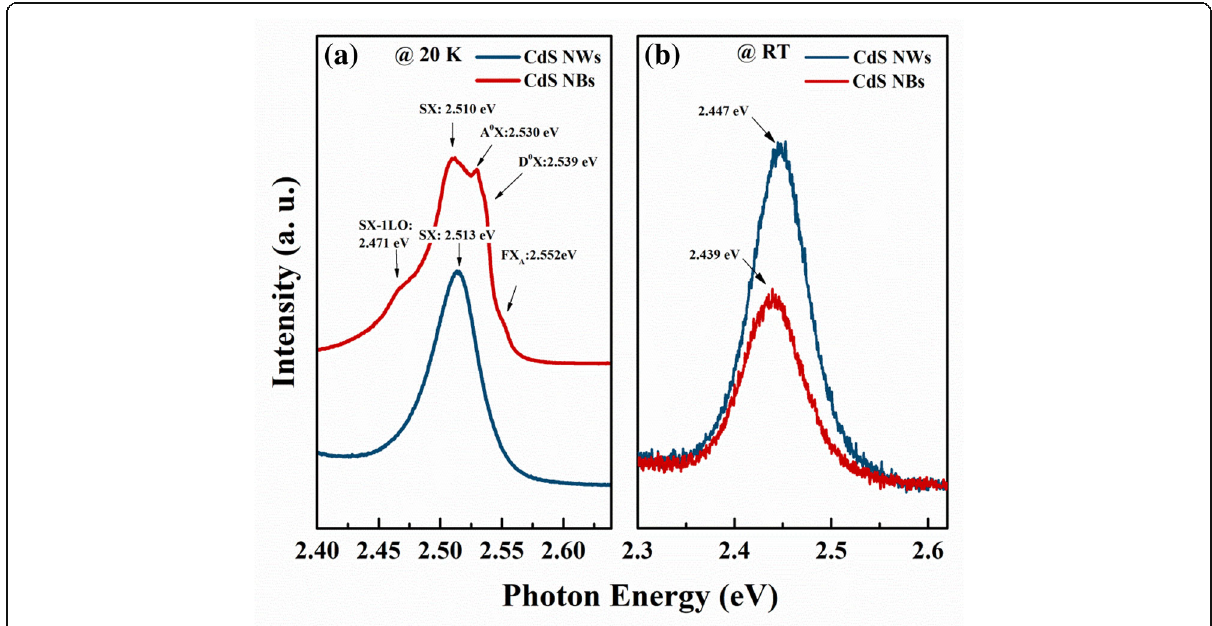
Fig. 1 The PL spectra of CdS NBs and NWs ( a ) at 20 K and ( b ) at room